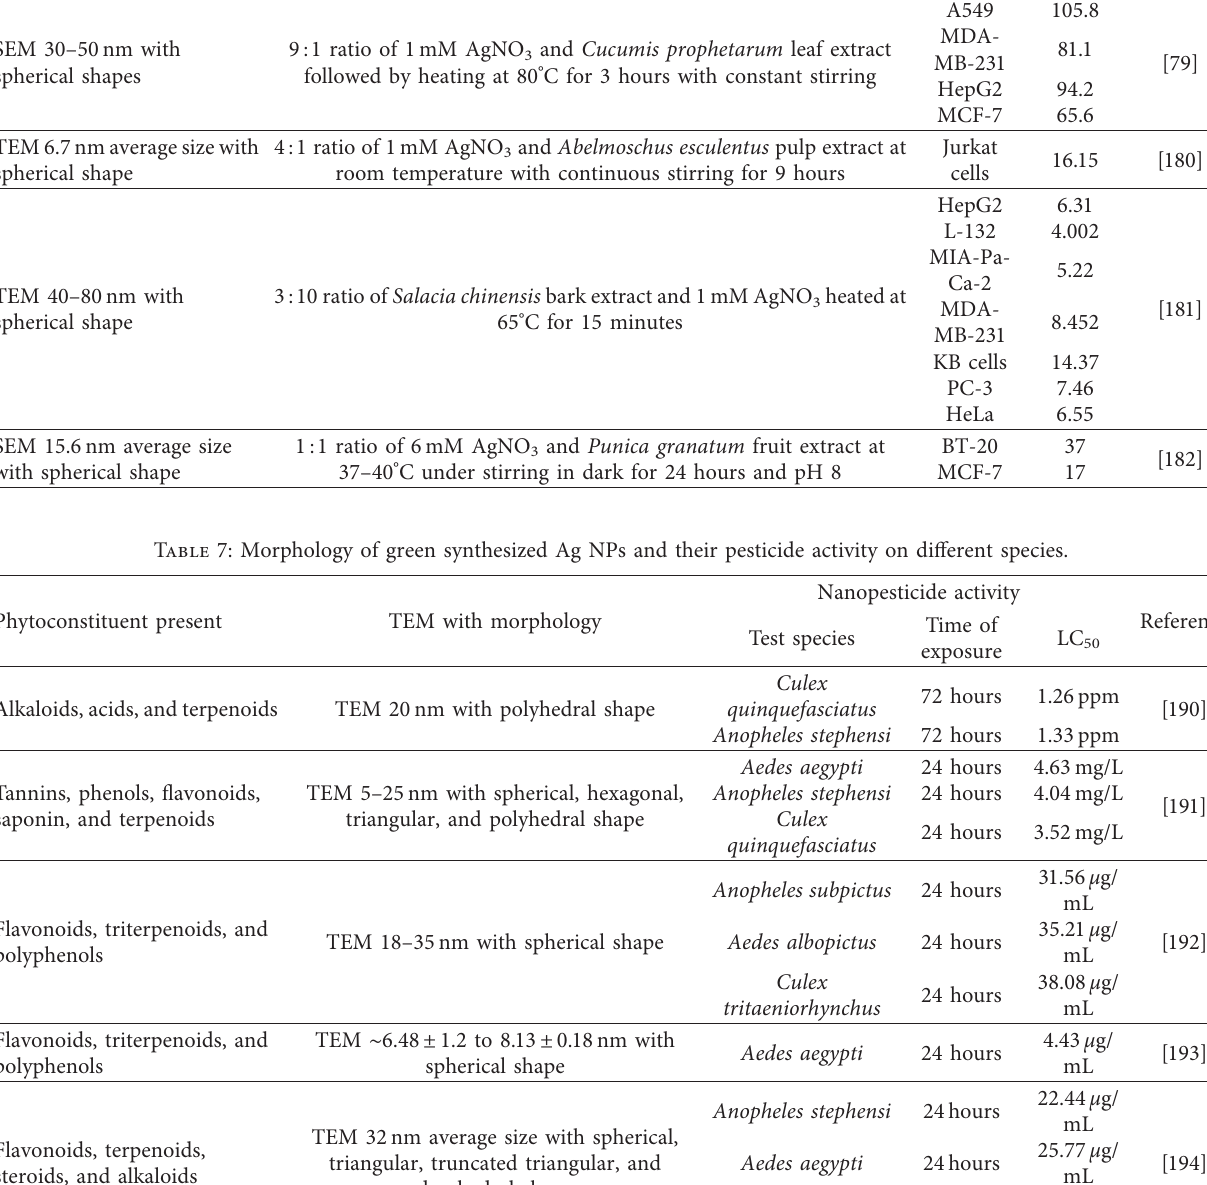
Flavonoids, triterpenoids,